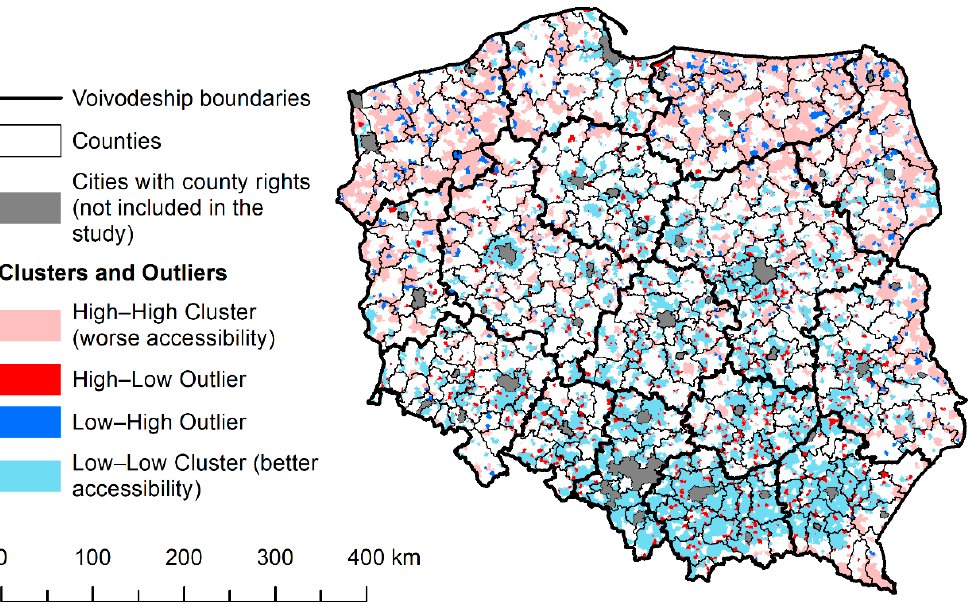
Figure 5. Distribution of clusters and outliers of spatial accessibility to PHC facilities in